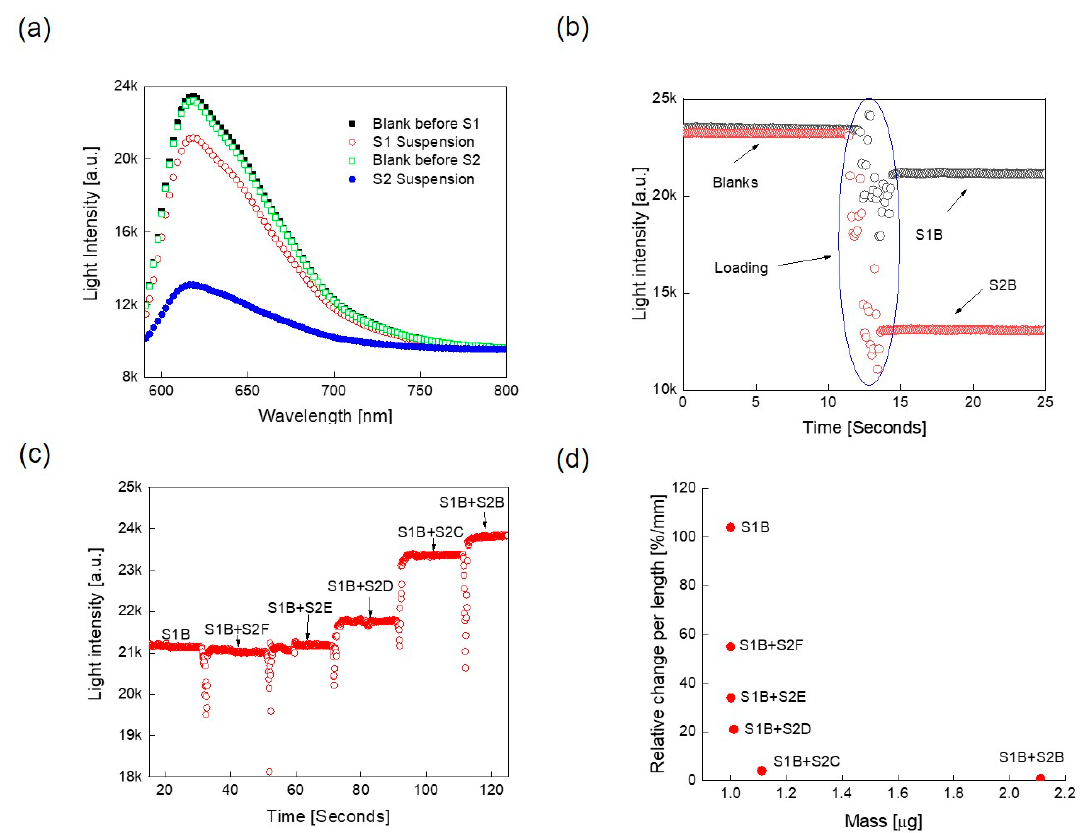
Figure 3. Optical measurements of the spike protein subunits S1 and S2: ( a ) measured responses for spikes proteins S1 and S2 at the highest concentration individually (S1B and S2B, respectively), along with their corresponding blanks. ( b ) Time domain measurements of the microcentrifuge tube, the blank (shown in gray circles) vs. water (red circles) at a wavelength of 623 nm. ( c ) Measured optical responses for the mixed protein samples vs. time. Samples S1B and S2B were at 5000 copies per ml, S2C, S2D, S2E, and S2F are the serial dilutions of S2B at 10-, 100-, 1000- and 10,000-fold, respectively. ( d ) Relative change in light intensity per light path vs. loaded mass. All optical responses were measured at 623 nm. Light intensity was measured as arbitrary units (a.u).